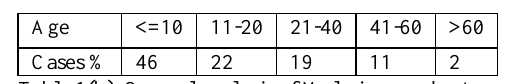
Table 1(b). General analysis of Malaria cases by